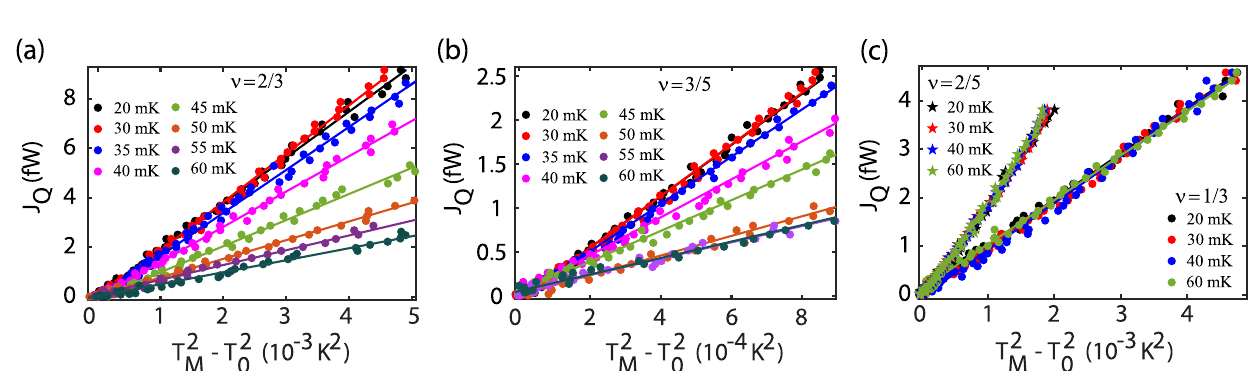
Fig.3|Temperaturedependenceofthermalconductances.a,b J Q (solidcircles) is plotted as a function of T 2 M (cid:2) T 2 0 at ν =2/3 ( a ) and ν =3/5 ( b ) at several values of thebathtemperature.Solidcirclesshowtheexperimentaldata,whilesolidlinesare linear fi ts to these experimental data points. Different colors correspond to dif- ferent bath temperatures as shown in the legend. c J Q (solid circles) is plotted as a